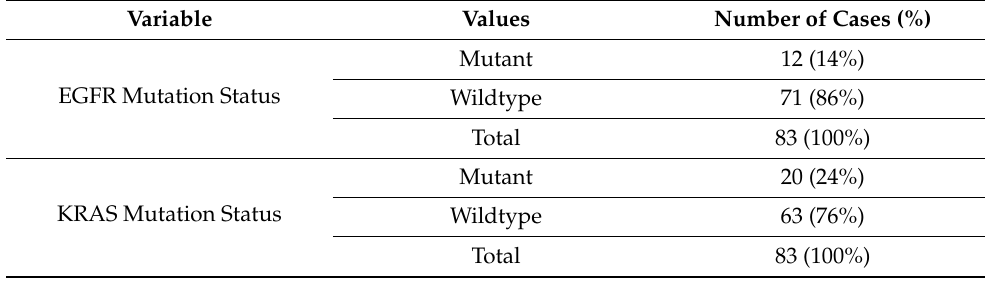
Table 1. Mutation status data summary.